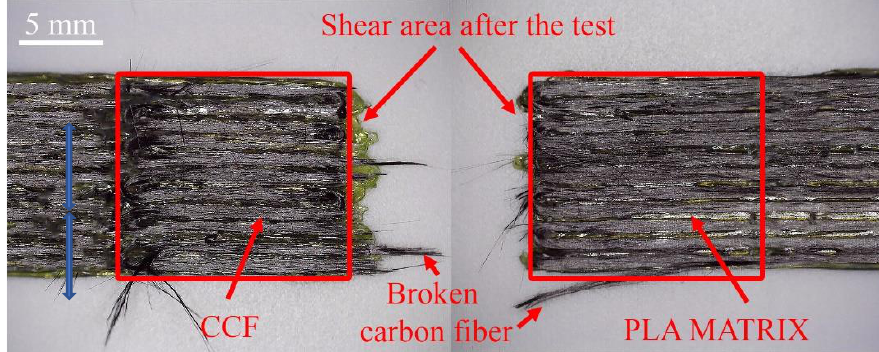
Figure 6. The 11 printing lines of the G3 group specimen after the test.